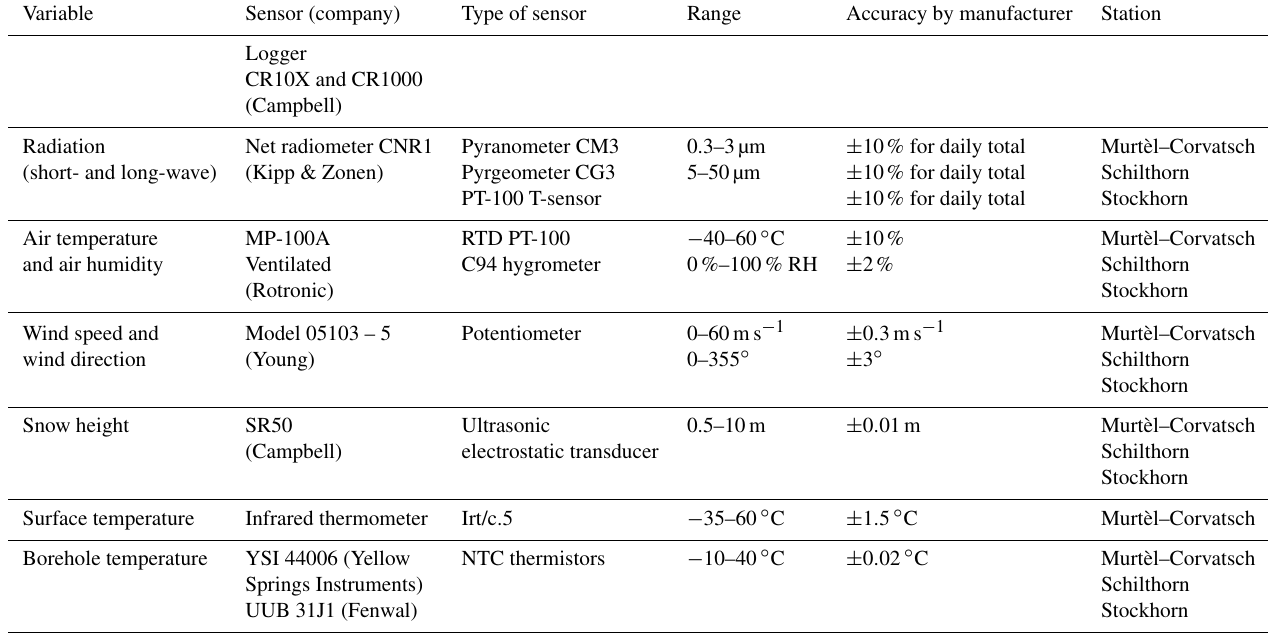
Table 1. Sensors currently used and their characteristics at the three different sites.